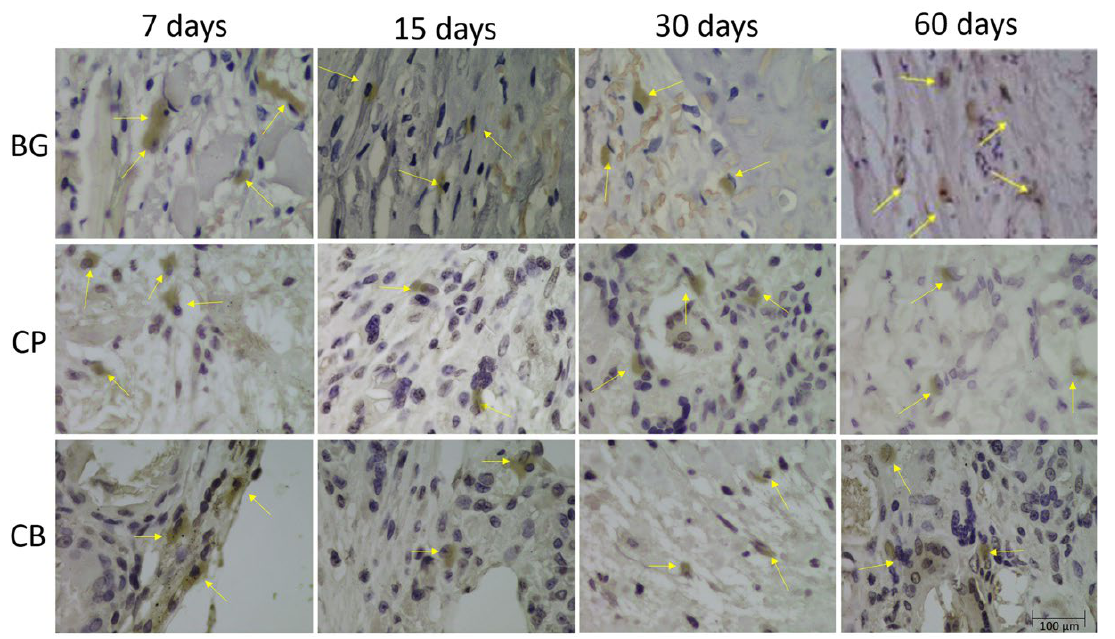
Figure 4. Photomicrographs of groups BG, CP and CB, during periods of bone repair at 100 × magnification, showing osteopontin immunostaining (yellow arrows).